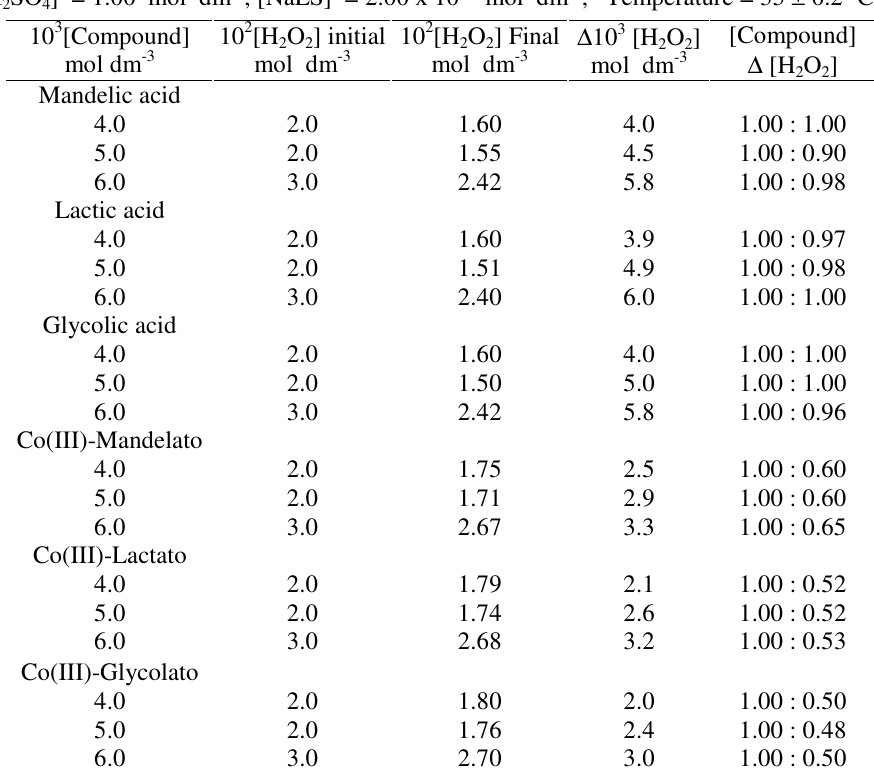
Table 1. Stoichiometric data for H acids in the presence of